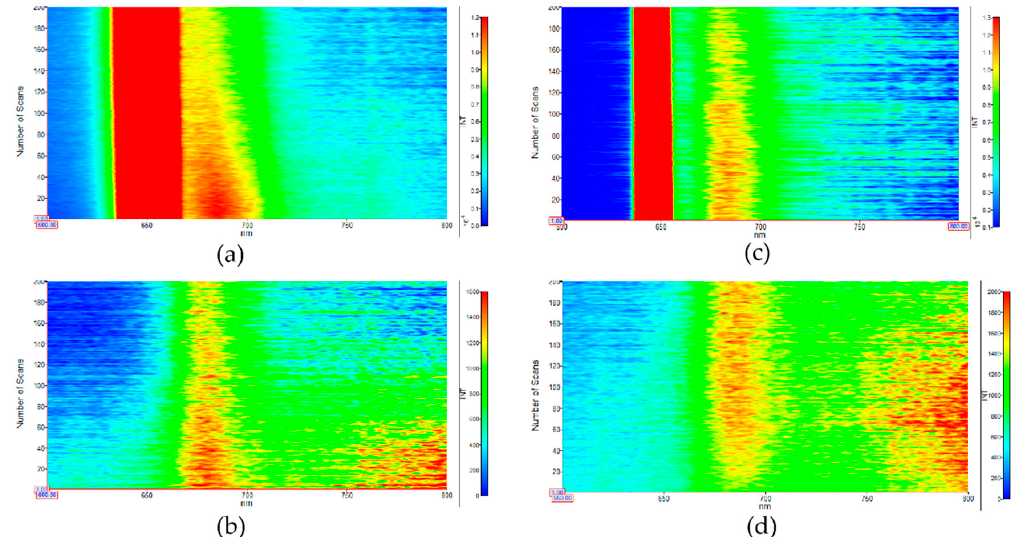
Figure 6. ( a , b ) In situ MB emission images for 3%CuO / CeO 2 / ZnO under the excitation wavelengths of 325 and 450 nm, respectively. ( c , d ) In situ MB emission images for pure ZnO under the excitation wavelengths of 325 and 450 nm, respectively. Scan number: 200, scan time: 300 min.